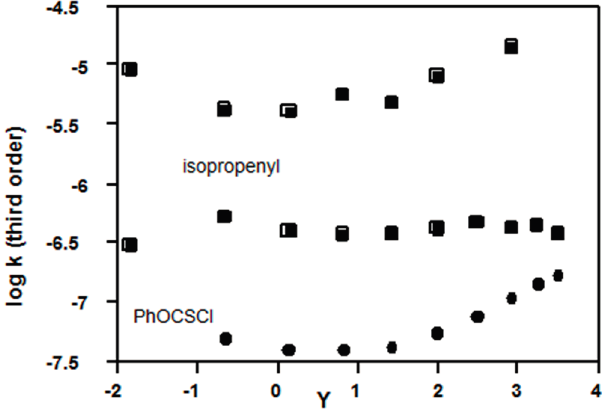
Figure 9. Plots of log k 3 vs. Y (Equation (3)) for solvolyses in acetone-water